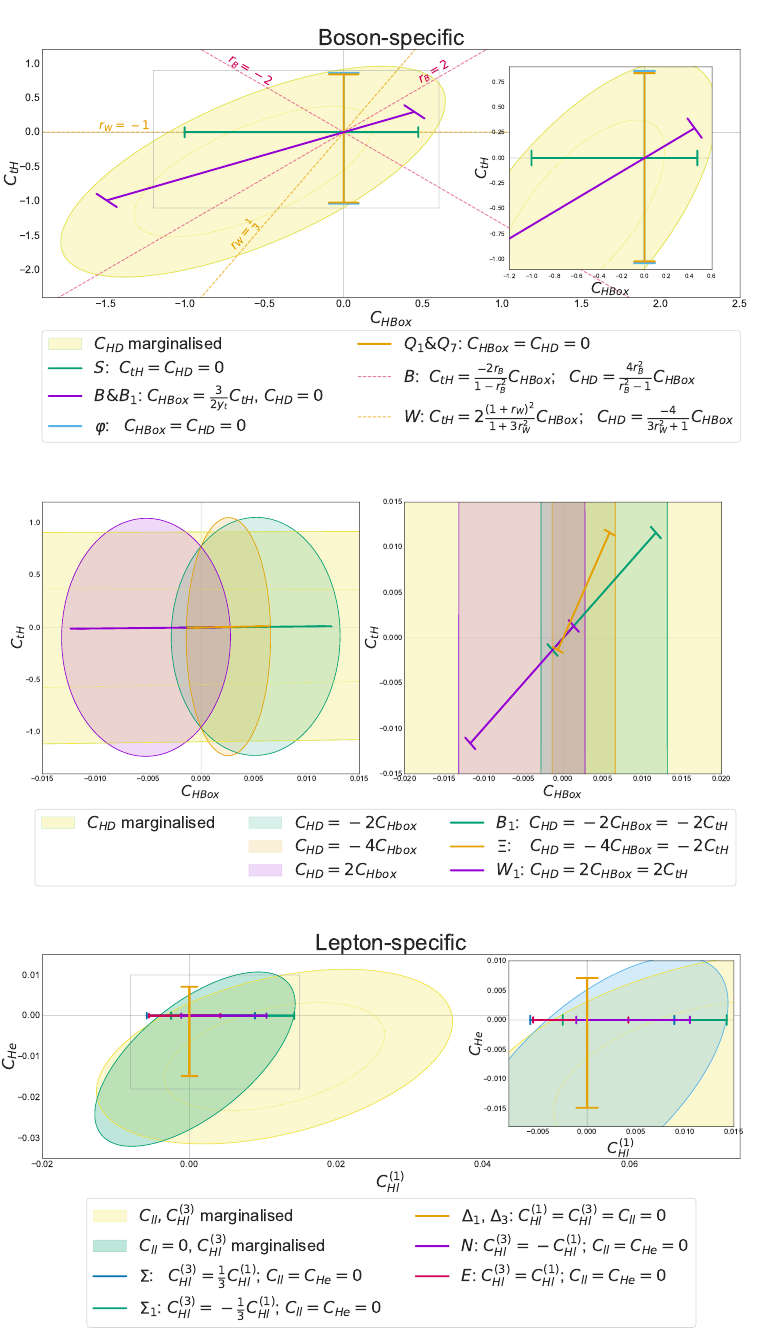
Figure 15 . Constraints at the 95% CL on ( C , C tH ) in the boson-specific scenario (upper two H (cid:3) panels) and ( C (1) , C He ) in the lepton-specific scenario (bottom panel). The lines correspond to the Hl 2- σ limits obtained when we restrict the operators to the relations generated by integrating out the indicated single-field extensions of the